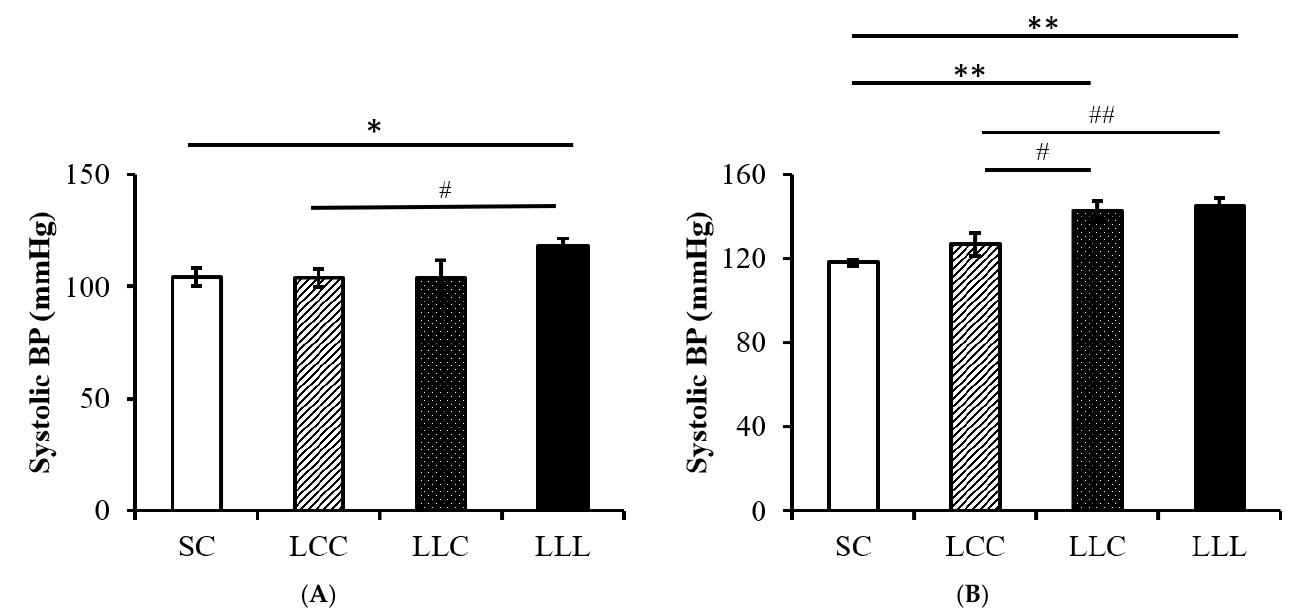
Figure 1. Blood pressure of offspring. ( A ) At 8 weeks old (N = 8 in each group). ( B ) At 16 weeks old. Four groups were evaluated by one-way ANOVA with the LSD post hoc test. * vs. SC, p < 0.05; ** vs. SC, p < 0.01; # vs. LCC, p < 0.05; ## vs. LCC, p < 0.01.